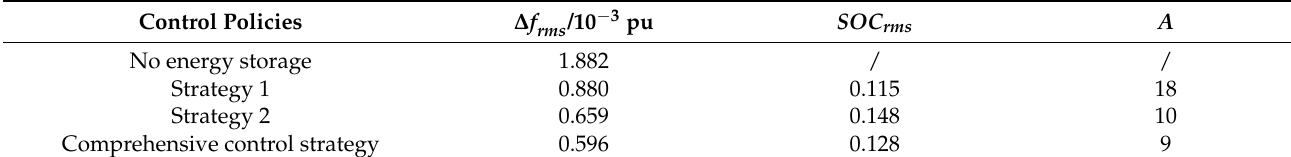
Figure 13. SOC curve of BES system under 10 min continuous load disturbance. Table 4. Evaluation index of FM under 10 min continuous load